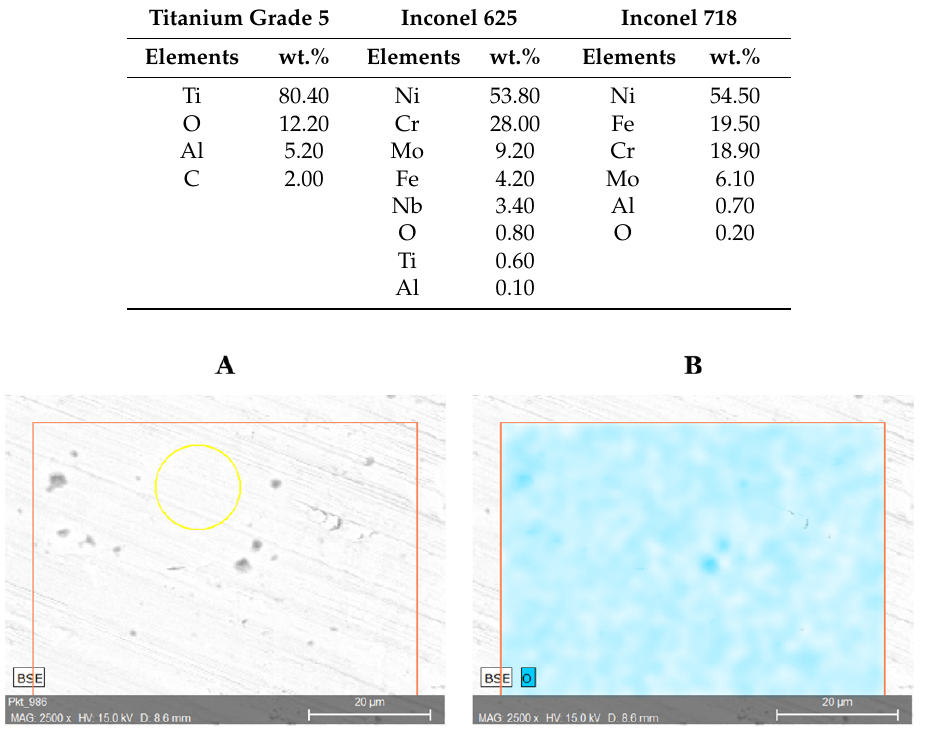
Figure 4. Analysis of the swarf surface of Inconel 718 ( A ); surface oxygen distribution of Inconel ( B ).